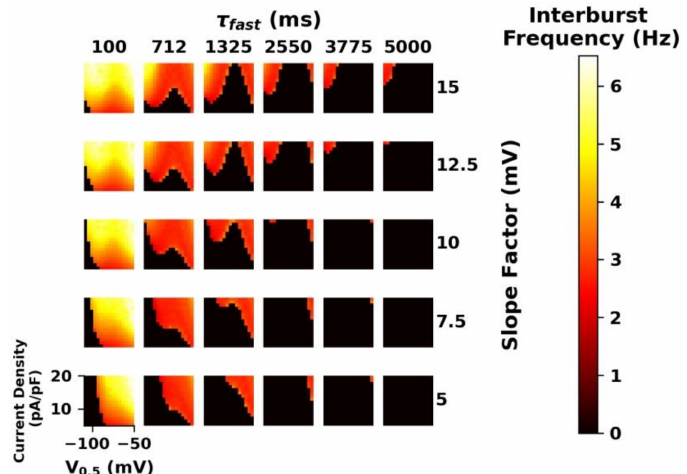
Figure 14. The NEURON-modeled influence of I h parameters on burst activity. The computer model was parameterized with a wider parameter space of I h characteristics (time constant tau fast, slope factor of the activation curve, current density and V 0.5 ). The resulting oscillatory activity is shown as a density blot for different conditions. Dark colors indicate slowed burst frequency, while bright colors represent higher burst